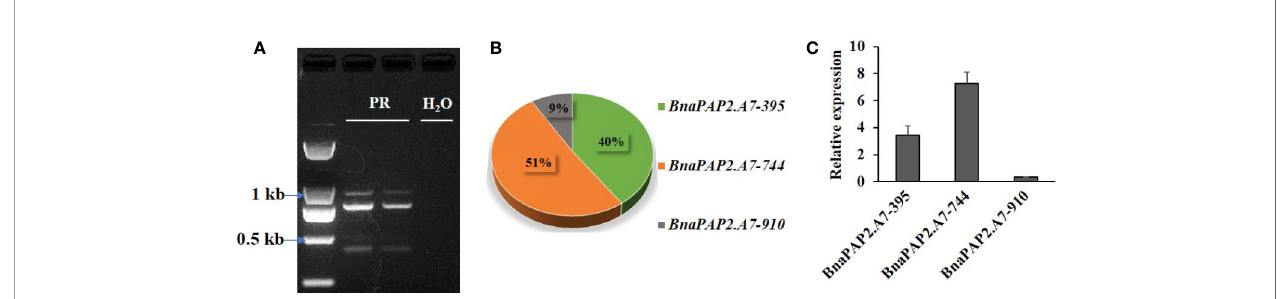
FIGURE 4 | Characterization the expression of three alternative spliced transcripts produced by BnaPAP2. A7 . (A) Detection of three isoforms by agarose gel electrophoresis. (B) Expression abundance analysis of three isoforms by colony PCR and agarose gel electrophoresis. (C) qRT-PCR analysis of three isoforms.